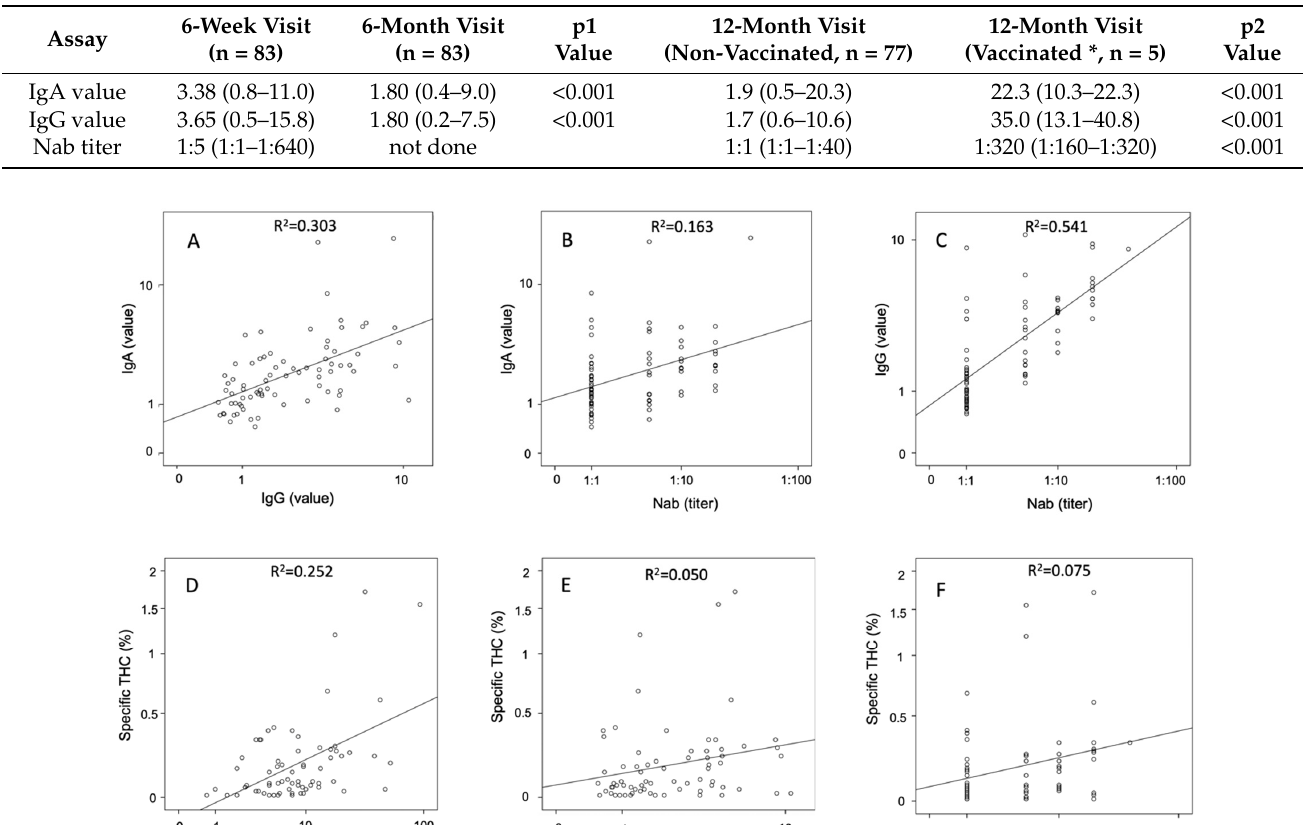
Table 2. Analysis of humoral immunity against SARS-CoV-2 at 6-week and 6-month follow-up (all participants non- vaccinated) as well as at 12-month follow-up grouped between vaccinated and non-vaccinated participants. Results are given as median values (range): Nab, neutralizing antibodies; *, at least 14 days before 12 months follow-up visit; p1 value, 6-week vs. 6-month; p2 value, vaccinated * vs. non-vaccinated at 12-months visit.